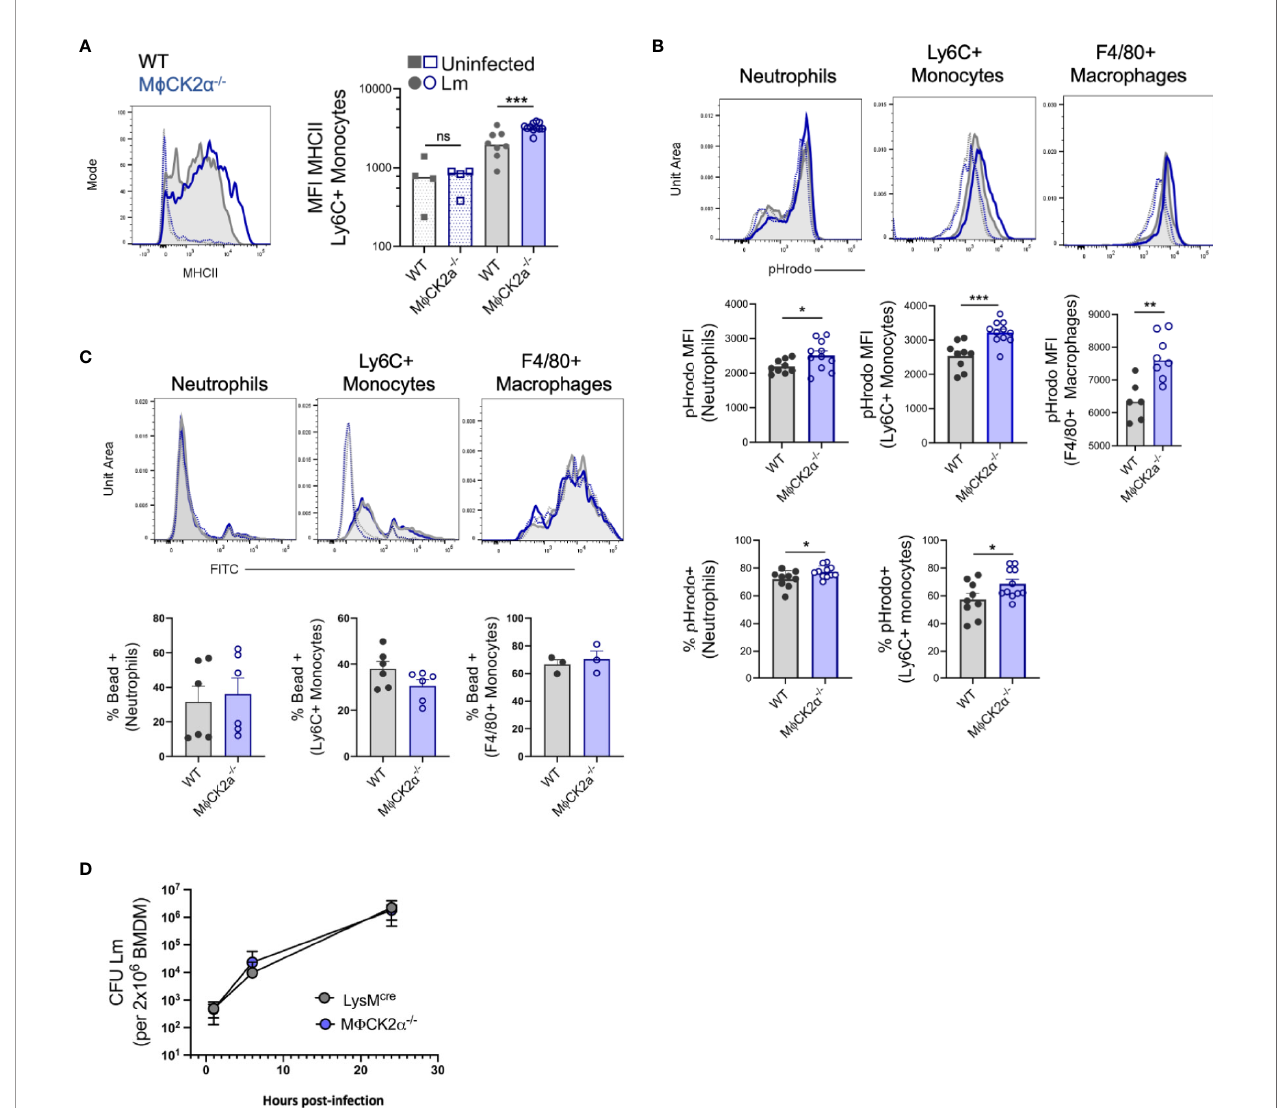
FIGURE 3 | Enhanced activation of in fl ammatory myeloid cells from M f CK2 a − / − mice. Splenocytes were harvested from uninfected and Lm infected WT or M f CK2 a − / − mice and (A) surface MHC II was evaluated on splenic Ly6C+ monocytes 2 dpi using fl ow cytometry. Histogram shows MHCII staining intensity on cells from uninfected (open, dotted line) and Lm-infected (solid line) WT (gray) and M f CK2 a − / − (blue) mice. Data are pooled from two experiments, n = 4 – 8 mice/group. (B) Splenocytes at 2 dpi were cultured 1 h with pHrodo particles. Fluorescence intensity of particles was evaluated on the indicated gated cells. Top histogram plots indicate fl uorescence for WT (gray, fi lled line) and M f CK2 a − / − (blue, open line) cells. Uninfected samples are of corresponding color (dotted line). Middle graphs depict quanti fi cation of pHrodo MFI. Bottom graphs enumerate the percentage of cells positive for pHrodo, as determined by -pHrodo control. Data are pooled from two to three experiments, n = 3 – 12 mice/group. (C) FITC fl uorescence intensity is shown in top histogram panels. Uninfected (open) and Lm-infected ( fi lled), WT (gray), and M f CK2 a − / − (blue) are overlaid. Below graphs quantify the percentage of FITC (bead) positive as determined by -bead controls. Data are pooled from one to two experiments, n = 6 mice/group. (D) Lm replication in bone marrow-derived macrophages (BMDMs) cultivated from WT (gray) and M f CK2 a − / − (blue) mice. BMDMs were plated 2 × 10e+6 per well and infected with 2 × 10e+5 live Lm. Shown is one of two experiments using BMDMs from two to three individual mice per genotype per experiment. *p < 0.05, **p < 0.01, ***p < 0.001 and ns = p < 0.05 as measured by students